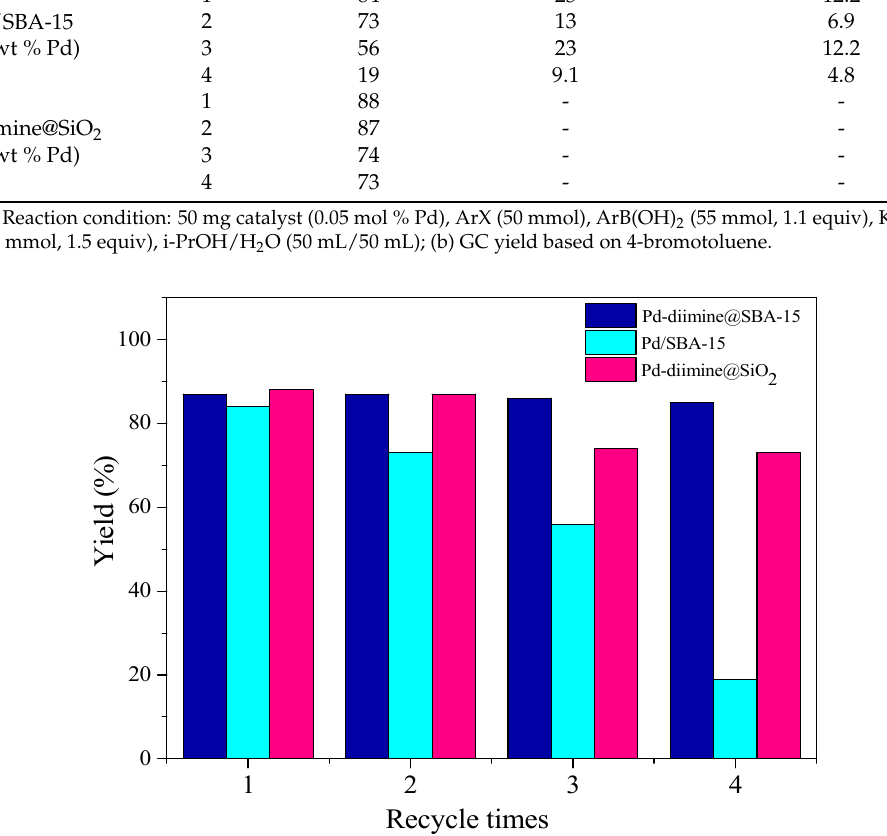
Figure 8. Repeated ‐ use testing of the Pd catalysts for the coupling reaction of bromobenzene and phenylboronic acid at 80 °C for 12 h. (Reaction condition: 50 mg catalyst (0.05 mol% Pd), ArX (50 mmol), ArB(OH) 2 (55 mmol, 1.1 equiv), K 3 PO 4 (75 mmol, 1.5 equiv), i ‐ PrOH/H 2 O (50 mL/50 mL)).